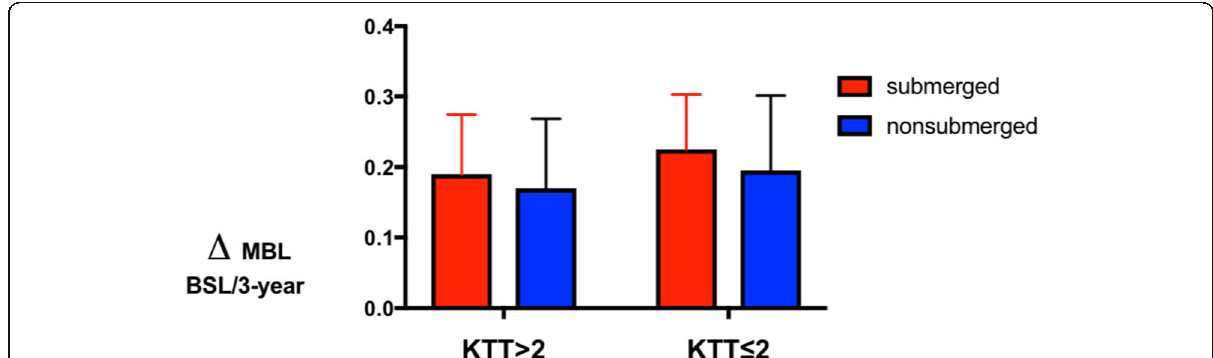
Fig. 7 Changes of CBL (mm) between the two groups in sites with KKT > 2 and ≤ 2 mm. ANOVA